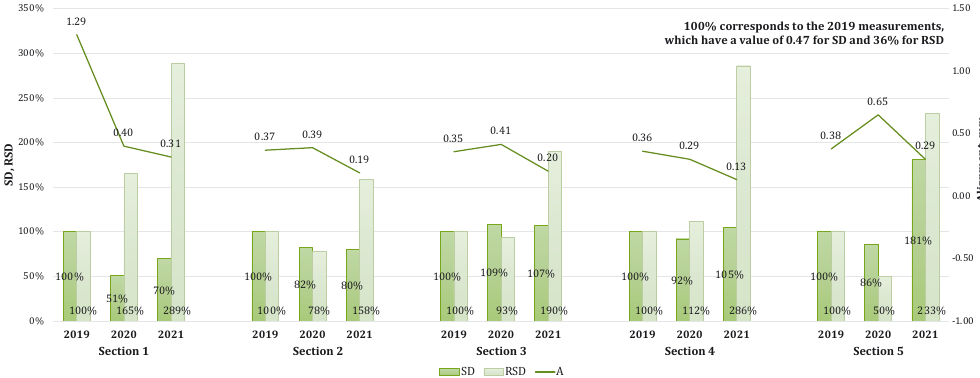
Figure 22. Statistical characteristics of the alignment values of the selected sections